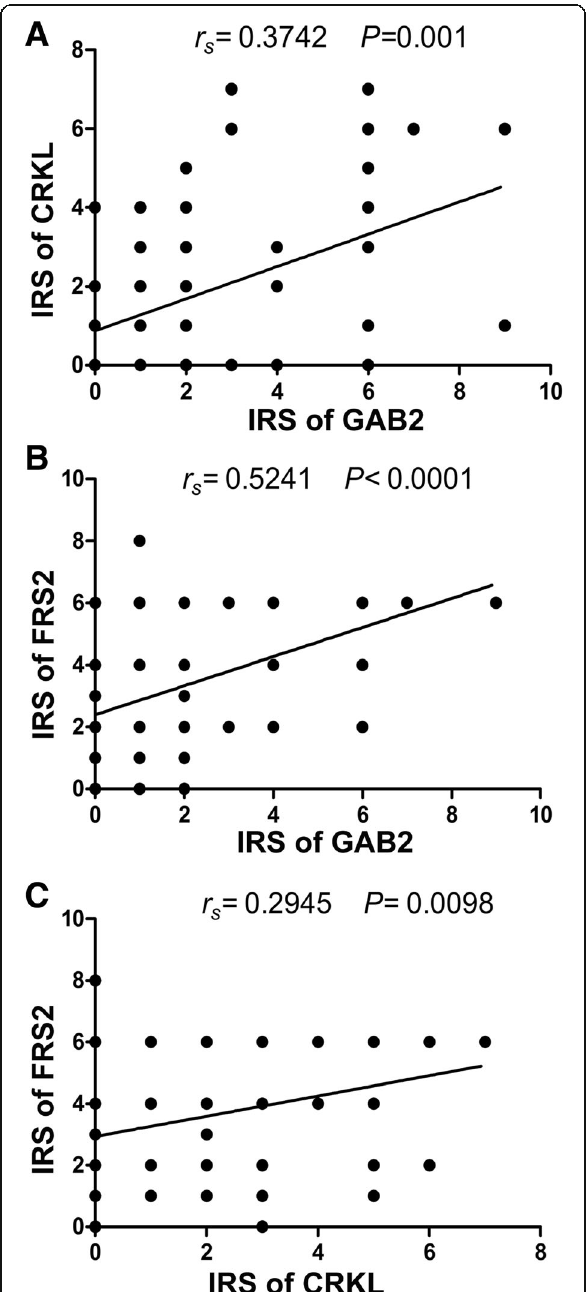
Fig. 3 Correlations between GAB2 and CRKL expression, GAB2 and FRS2 expression, and CRKL and FRS2 expression in PDAC: GAB2 expression correlated with CRKL ( r = 0.3742, P = 0.001) ( a ) GAB2 expression correlated with FRS2 ( r = 0.5241, P < 0.001) ( b ) CRKL expression correlated with FRS2 ( r = 0.2945, P = 0.0098) ( c